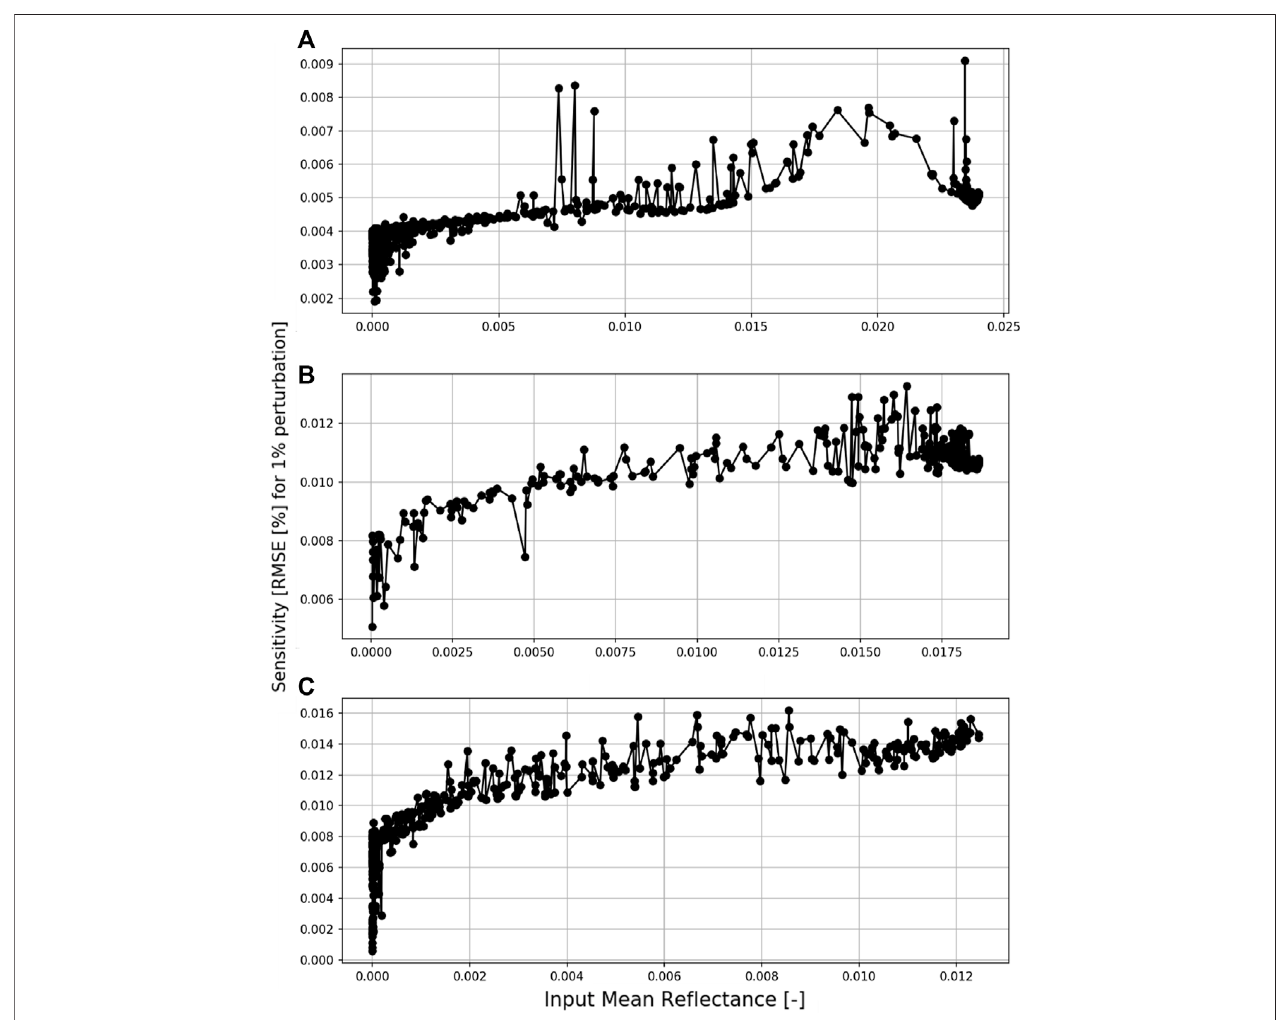
FIGURE9| SensitivityofmodelerrortoindividualinputwavelengthsforO2A-band (A) ,WCO2-band (B) ,andSCO2-band (C) .Note:they-and x -axishavedifferent scales for each plot.